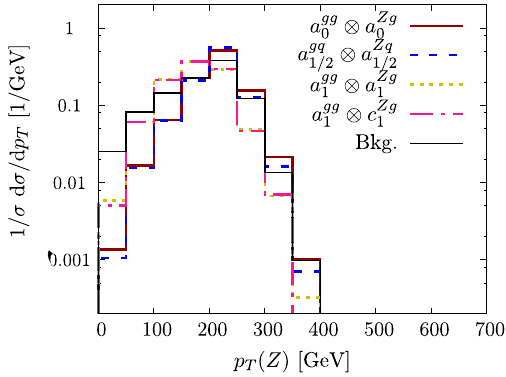
Fig. 6 Normalised transverse momentum distribution for jet+ Z pro- duction, focussing on representative spin 0 , 1 / 2 , 1 and coupling prop- erties of Sect. 2 (no jet-merging and detector resolution effects). See caption of Fig. 2 for further details on the notation